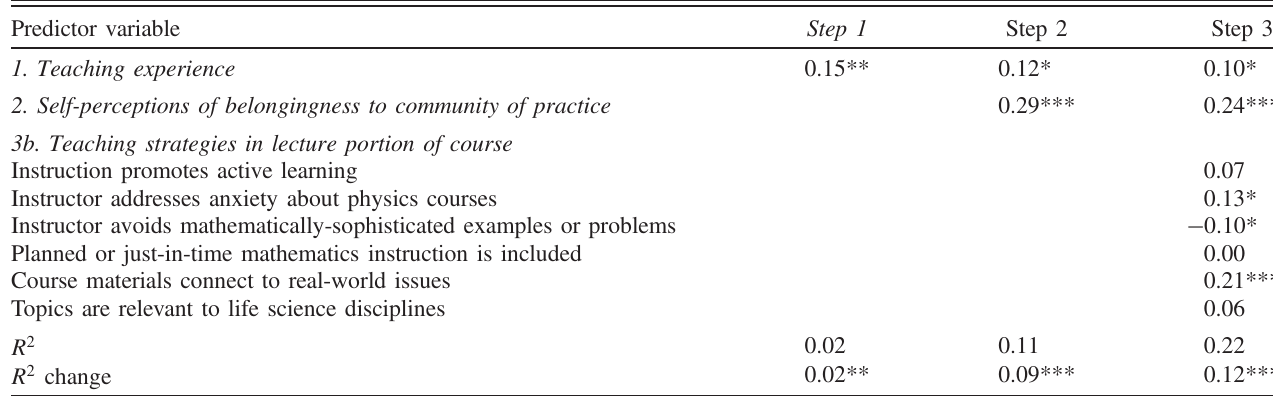
TABLE III. Summary of hierarchical regression analyses predicting perceived course effectiveness in engaging students from teaching experience, self-perceptions of belongingness to community of practice, and teaching strategies in lecture portion of course. Predictor variable Step 1 Step 2 Step